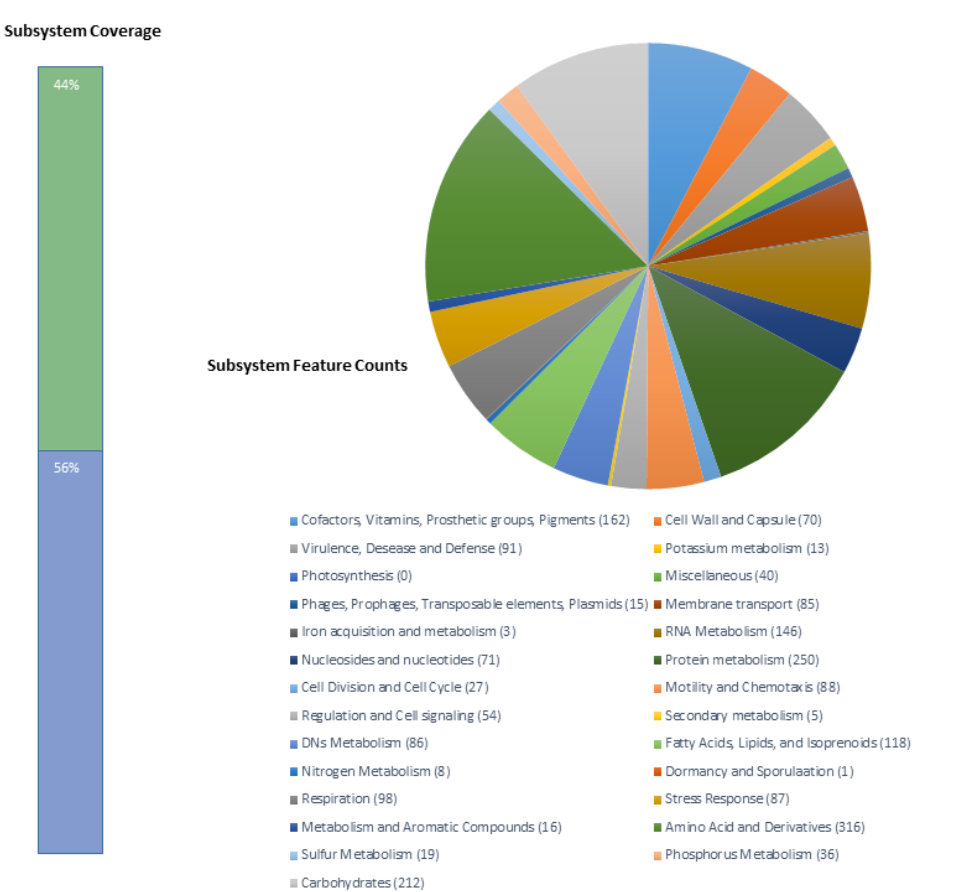
Figure 2. Subsystems distribution statistic of Brevundimonas sp. B10, based on RAST annotation server.